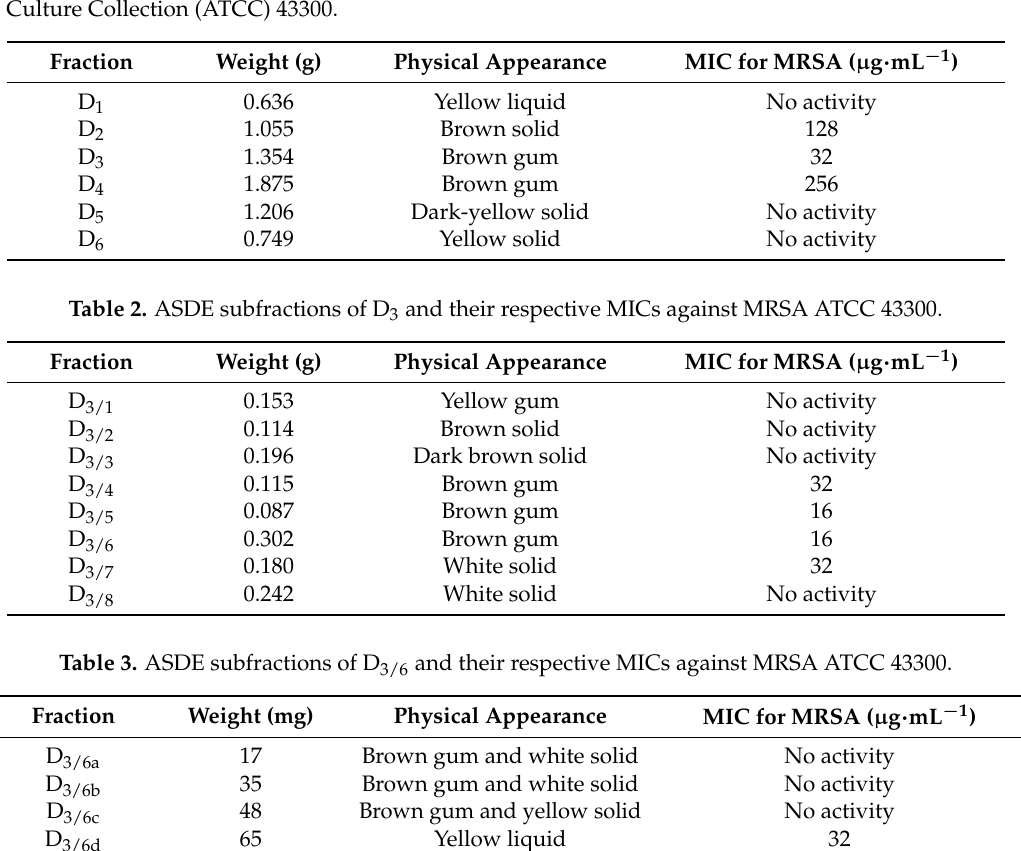
(Figure 1) based on spectroscopic methods.